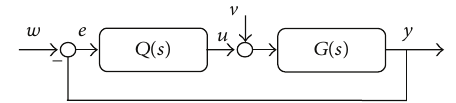
Figure 10: One degree-of-freedom (1DOF) control configuration.